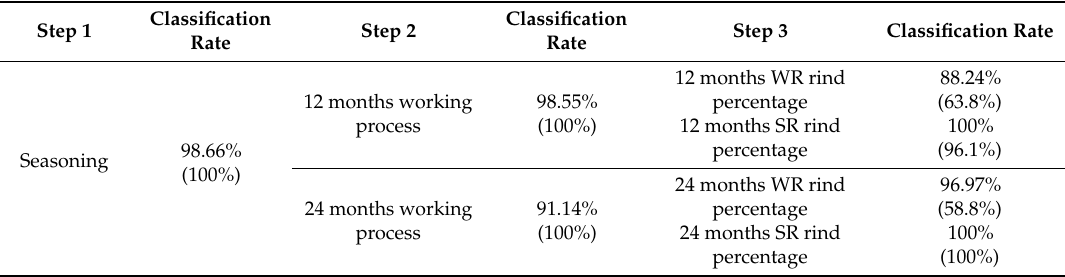
Table 4. Classification rates in the percentage of ANNs for each step. In brackets, the results of the previous work are